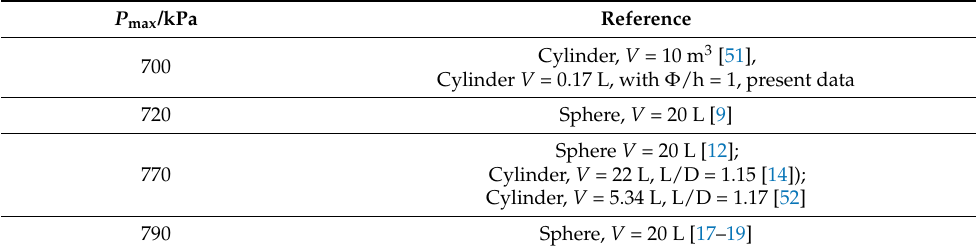
Figure 9. Experimental maximum explosion pressures for CH 4 –air mixtures at ambient initial conditions and in the presence of the radioactive 60 Co source. Table 5. Experimental explosion pressures of methane–air mixtures in vessels with central ignition at ambient initial conditions at 9.5% vol.